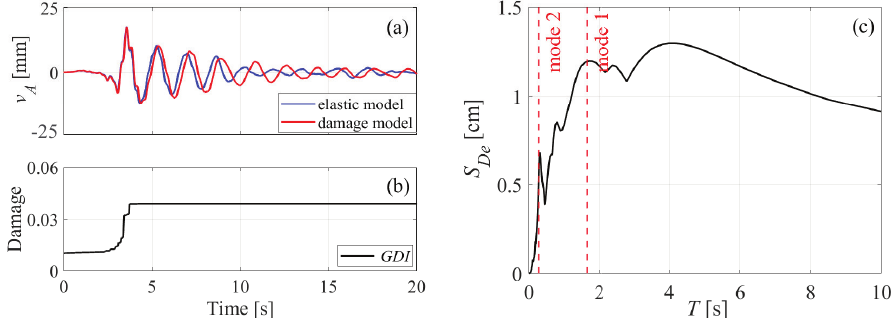
Figure 10. Earthquake RM03 station: ( a ) elastic and damage responses of the equivalent pier, ( b ) evolution of the GDI , ( c ) elastic displacement